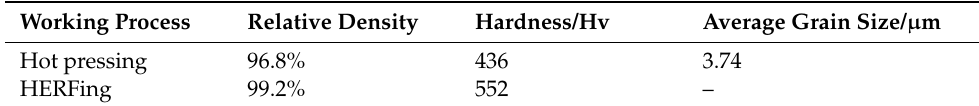
Table 1. Working process, relative density, and hardness of the WTC alloy. Working Process Relative Density Hardness/Hv Hot pressing HERFing